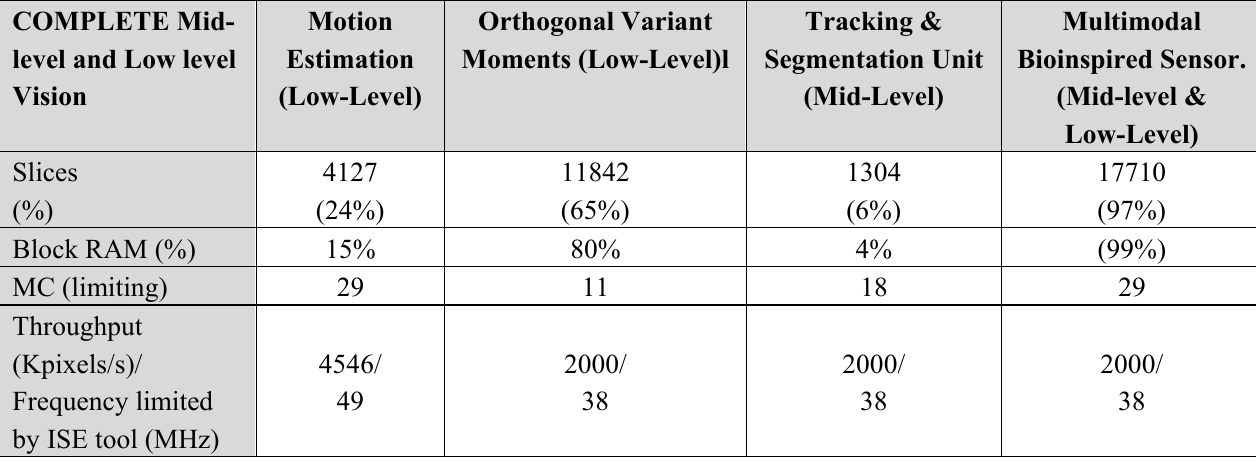
Table 3. Slices, memory requirements, number of cycles and performance for the implementation of Low and Mid-Level vision. Multimodal Bioinspired Sensor.